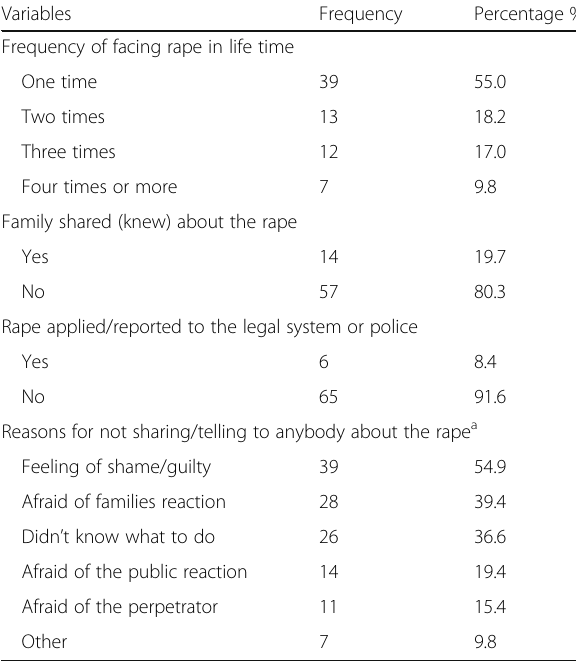
Table 3 Victim students ’ frequency and tendency of reporting